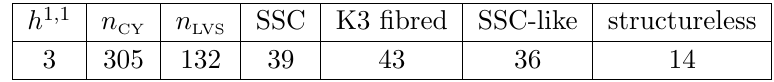
of diagonal dP divisors. ddP